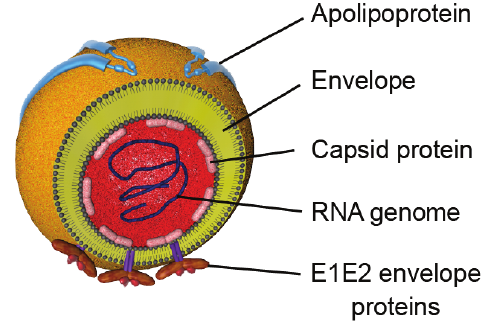
Figure 2. Schematic representation of HCV particles. Viral particles are composed of a nucleocapsid containing the viral RNA surrounded by a host cell-derived lipid envelope in which the E1 and E2 envelope glycoproteins are embedded. Apolipoproteins that are associated with particles are